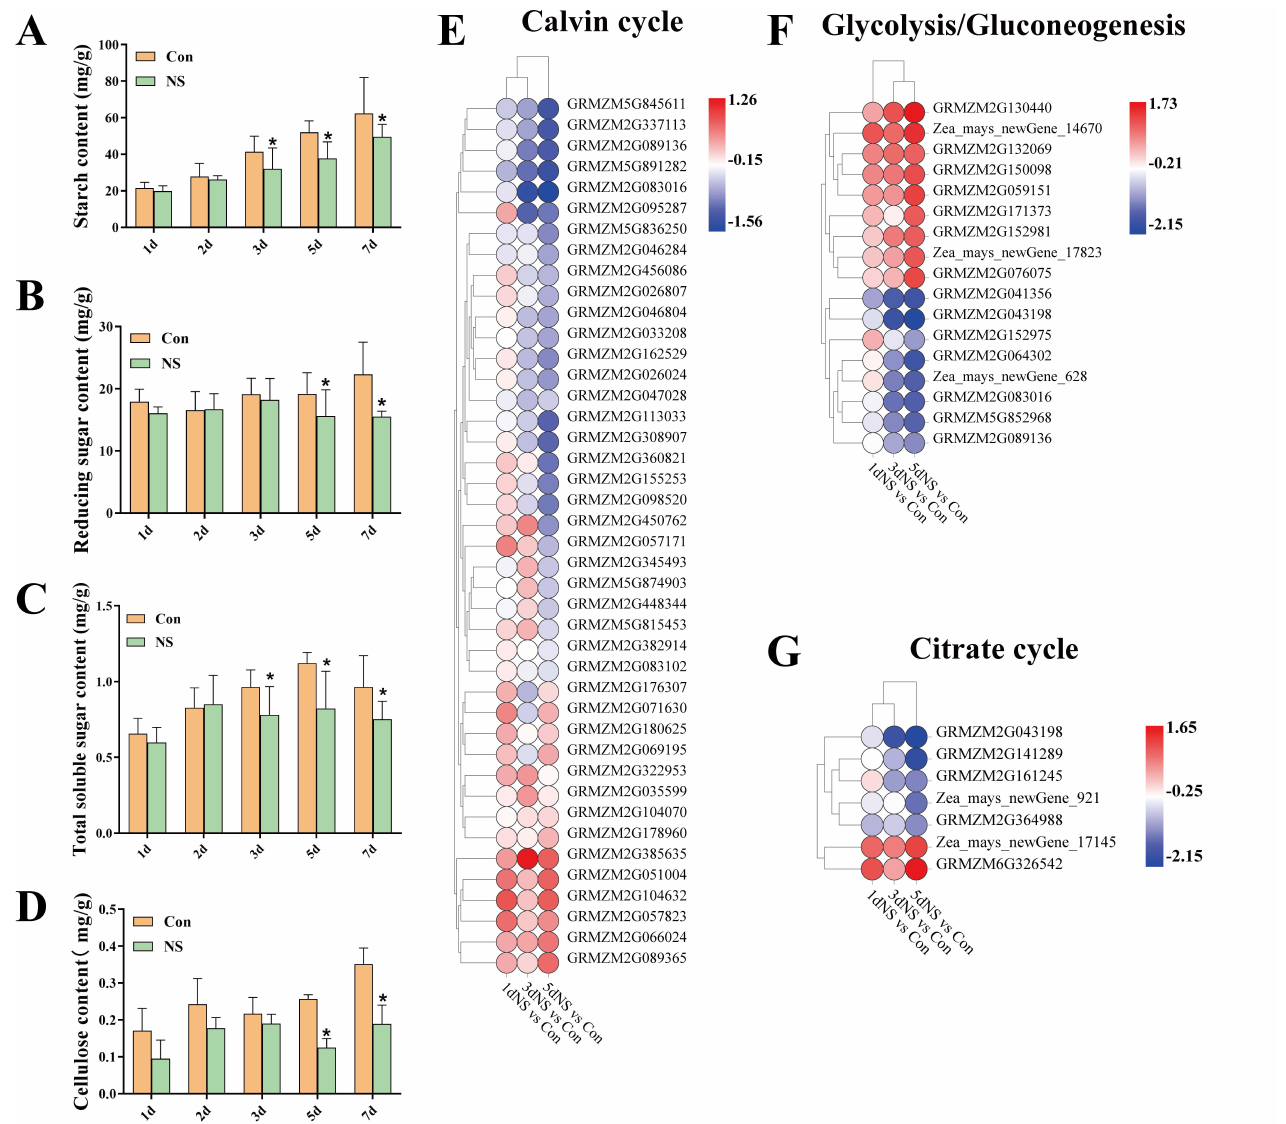
Figure 5. Analysis of carbon metabolism in maize seedling leaves under phospholipase C inhibition. ( A ), changes in reducing sugar content; ( B ), changes in starch content; ( C ), changes in total soluble sugar content; ( D ), changes in cellulose content; ( E ), Calvin cycle pa − 1thway DEGs; ( F ), glycoly- sis/gluconeogenesis pathway DEGs; ( G ), tricarboxylic acid cycle pathway DEGs. Values are shown as mean ± SD ( n = 3 individuals per group). * means that the difference from the control reaches a significant level, p <